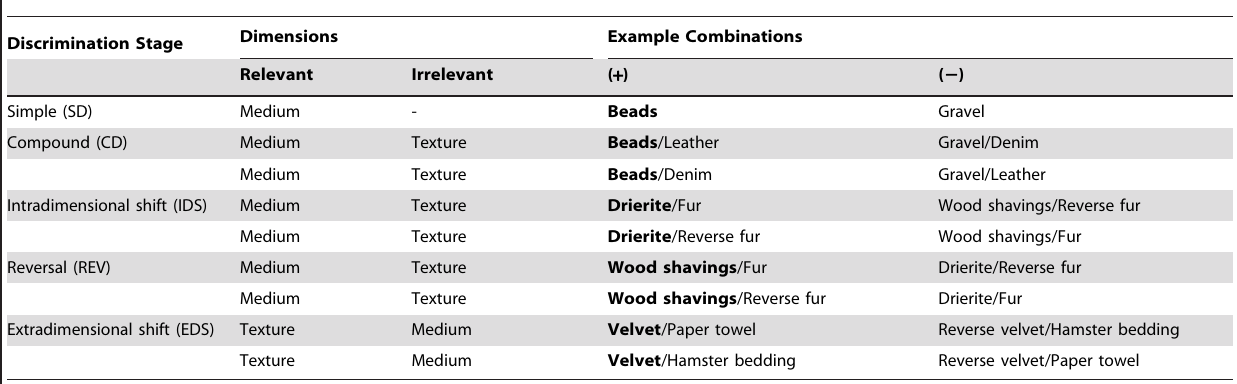
Table 1. Behavioral protocol for attentional set shifting.